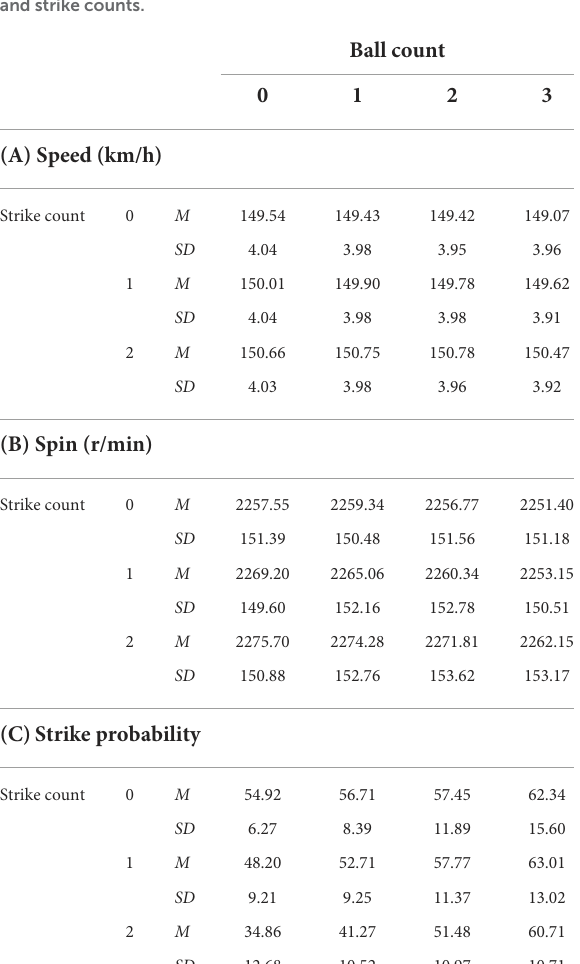
TABLE 4 Release speed and spin rate for the 4-seam pitch type by ball and strike counts.